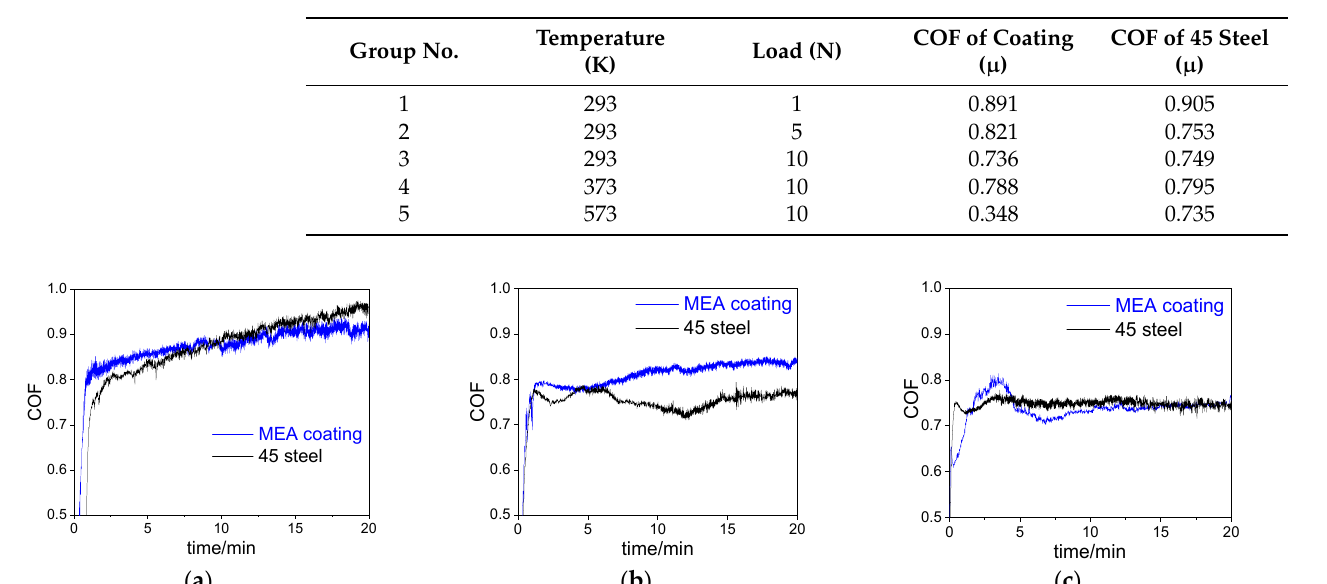
( c ) Figure 6. Friction coefficient curves at different temperatures (10 N): ( a ) 293 K; ( b ) 373 K; ( c ) 573 K. As shown in Figure 5, the average COF of the MEA coating decreased slightly when the load was increased from 1 N to 10 N. The change in COF of the 45 steel exhibited a similar trend. The coating and the steel had similar COFs. However, the coating had a much lower COF at 573 K, with a COF equal to 0.348, which is less than half its COF at room temperature (RT). However, the steel substrate did not change much within the temperature range. Volume losses caused by wear during the friction/wear tests were determined. Figure 7 illustrates the morphology of the wear tracks on the Fe 6 CoCrNiAl coating, showing fur- rows and grooves (Figures 7a–c). The surface damage to the coating was primarily caused by abrasive wear. Since the counter-part was an Si 3 N 4 ceramic ball with high rigidity, the abrasive particles were the debris falling from the surface of the coating. The width of the wear track increased with increasing load. With an increase in the temperature, the width of wear track slightly decreased. When tested at 575 K, the surface of the sample displayed noticeable oxidation. ( a )